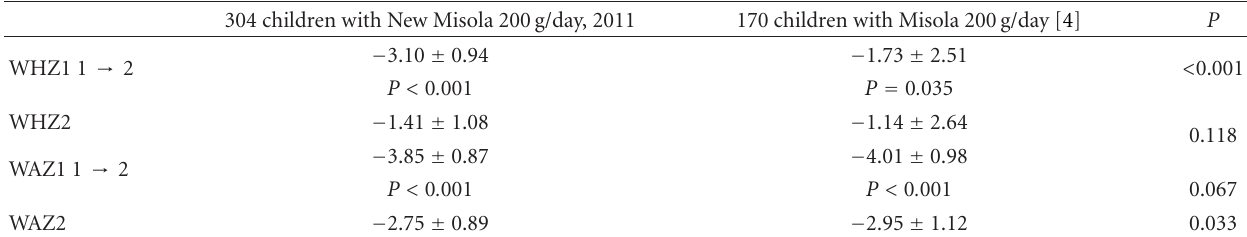
Table 6: Nutritional status at the beginning 1 and end of the study